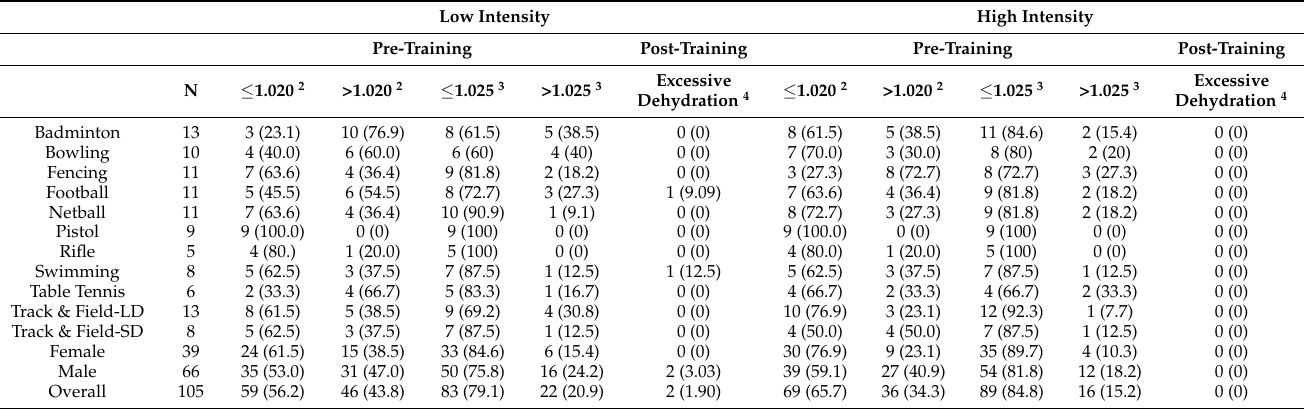
Table 2. Pre- and post-training hydration status 1,2 .